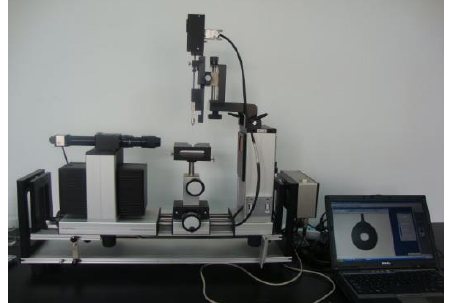
Figure 2. OCA20 video contact angle measurement.